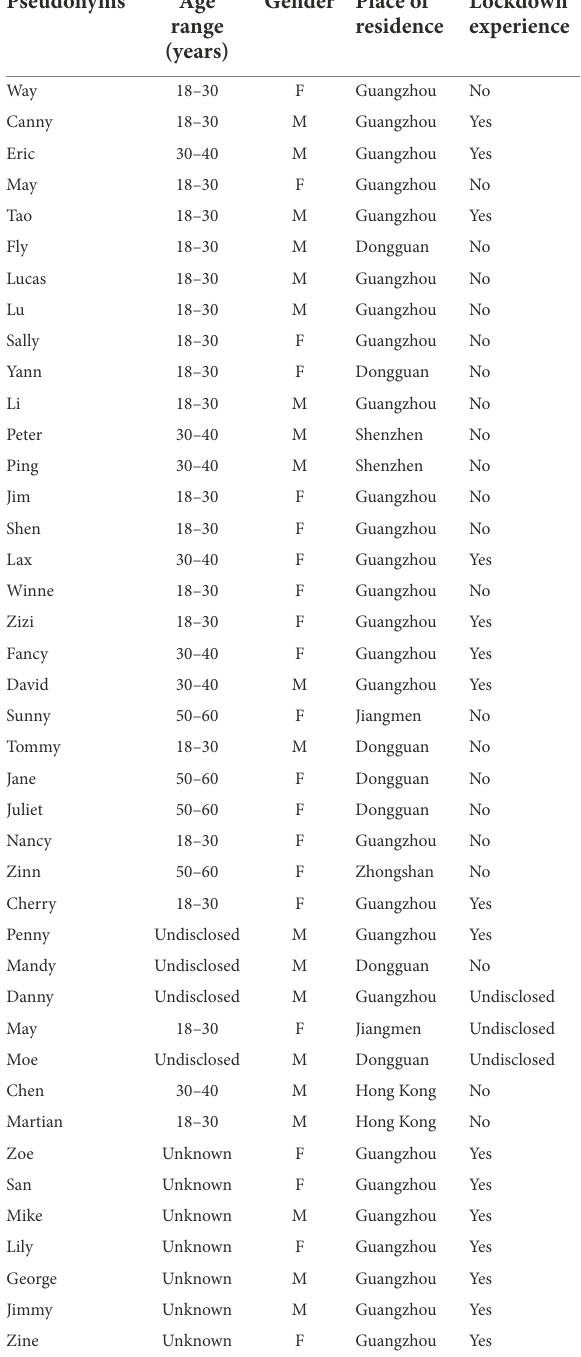
TABLE 1 Demographic information of